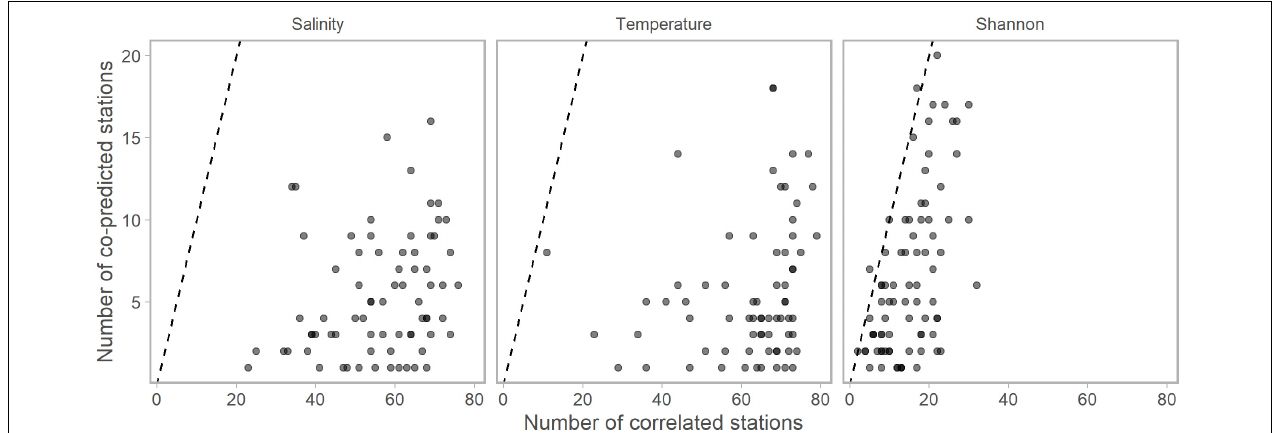
FIGURE 2 | The numbers of significantly correlated vs. numbers of significantly co-predicted stations for salinity, temperature, and Shannon indices of diversity. Each point represents the numbers of each correlated or co-predicted with a particular station (e.g., station A is correlated with 70 stations and co-predicted with 10 stations). Points are slightly transparent to allow overplotting. For nearly all stations, the numbers of correlated stations were higher than the number of co-predicted stations. Dashed lines indicate the one to one line. Composite libraries were composed of correlated or co-predicted stations based on these results.